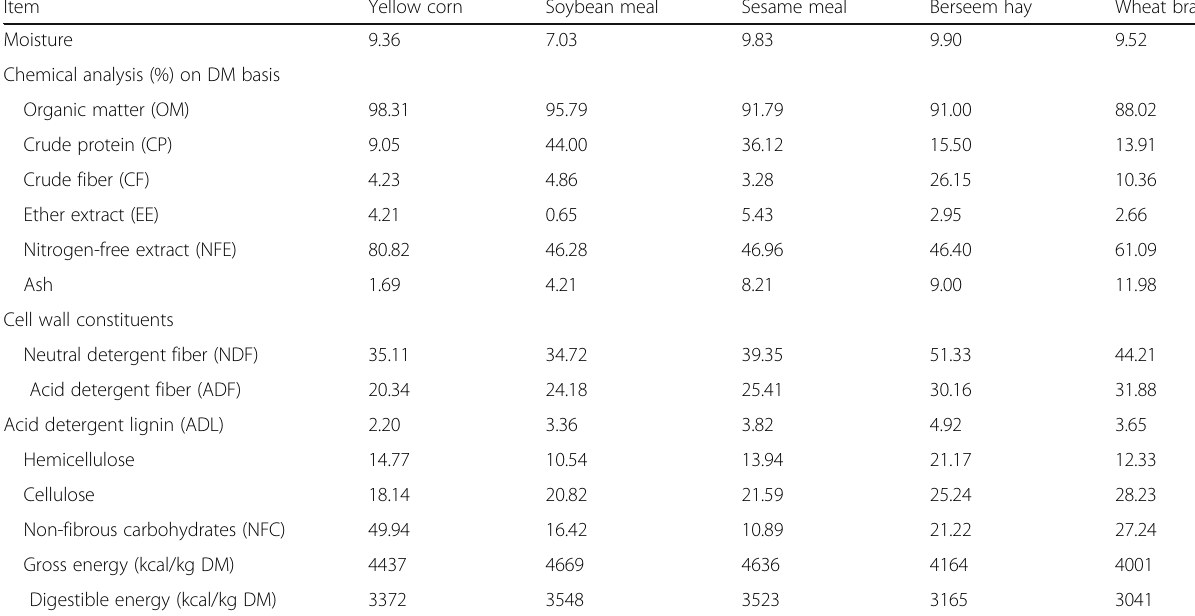
Table 1 Chemical analysis and cell wall constituents of different ingredients used in ration formulation Item Yellow